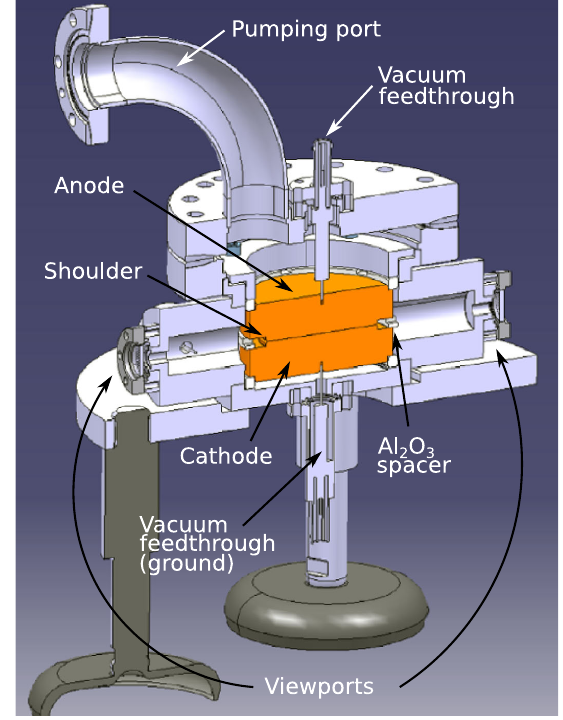
FIG. 1. A cross section from a 3D model of the LES vacuum chamber. The illustration shows the electrodes in the middle, connected to vacuum feedthroughs and otherwise insulated by an Al 2 O 3 spacer. Four viewports on the sides of the chamber allow also visual detection of a